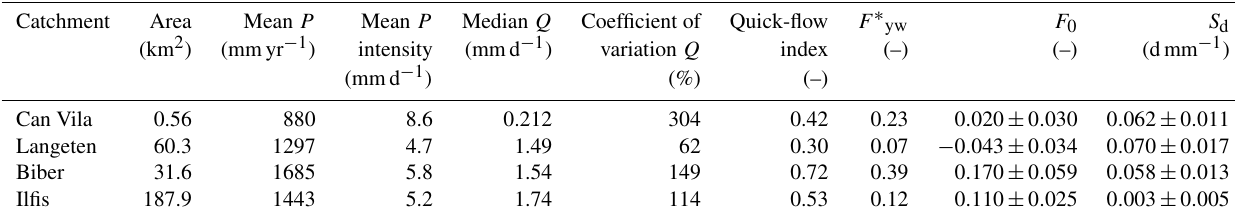
Table 1. Main characteristics and metrics of the catchments shown in Figs. 2 and 3. P is precipitation, Q is the stream discharge, F ∗ yw is the flow-weighted young water fraction, F 0 is the virtual young water fraction for zero flow, and S d is the proposed discharge sensitivity metric of the young water fraction. F 0 and S d are defined in Eq. (6).